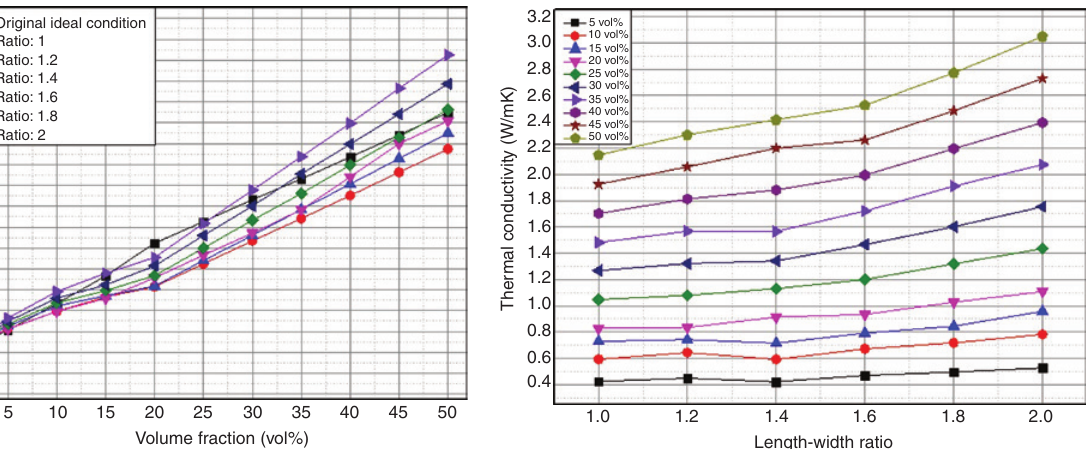
Figure 4: Investigation of the influence from the dependence on the shape and the length-width ratio of rectangular particles.